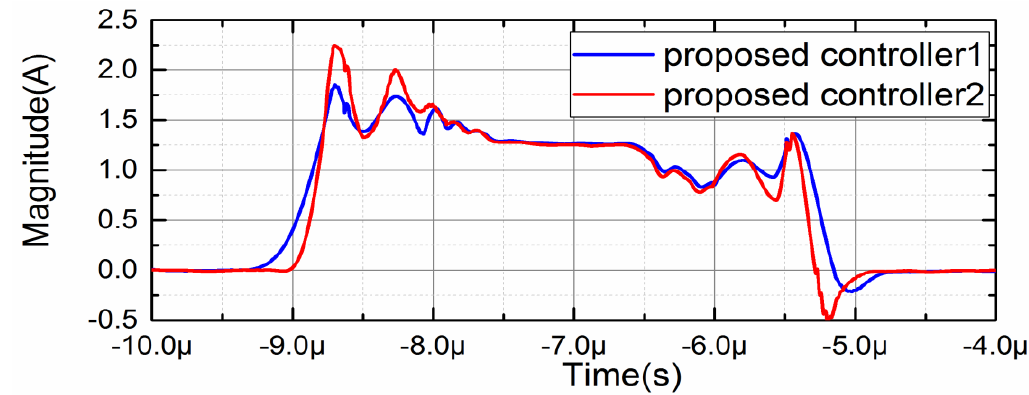
Figure 17. Experiment results of I d for turn-on and off transition between controller 1 (t off = t fall = 1 µs of V i ) and controller 2 (t off = t fall = 0.5 µs of V i ). Same reference voltage V f was used in controller 1 and controller 2.